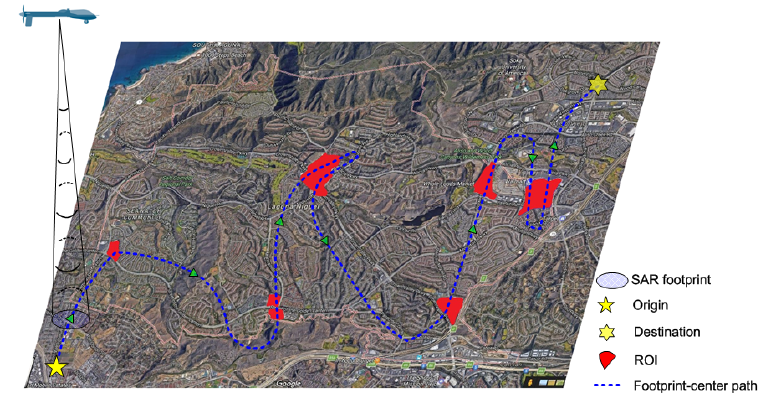
Figure 1. Illustration of multiregion surveillance by a single lightweight UAV